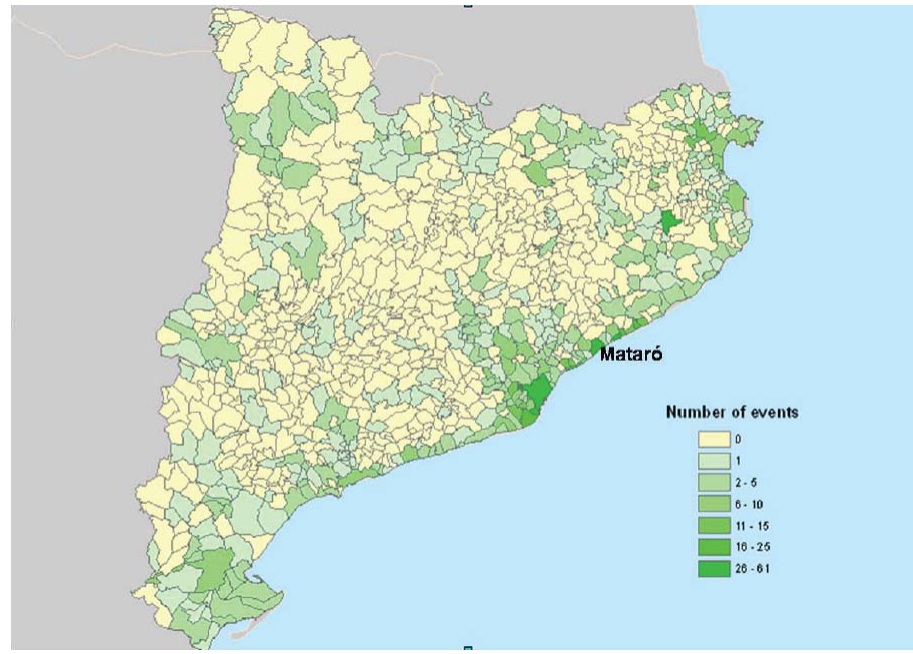
Figure 8. Number of flood events by municipality for the period 1901-2000 (Barnolas and